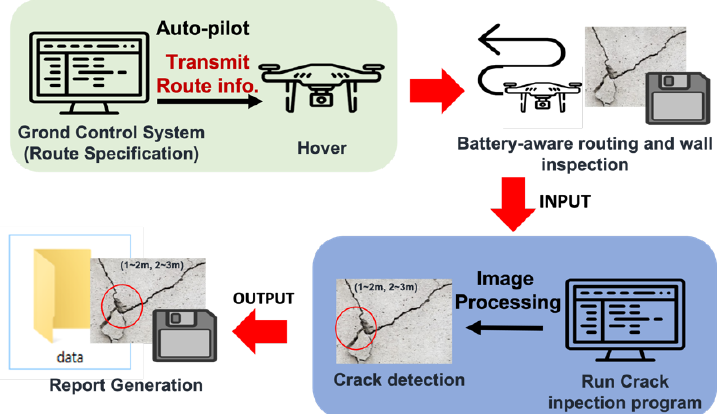
Figure 1. Wall crack inspection framework .